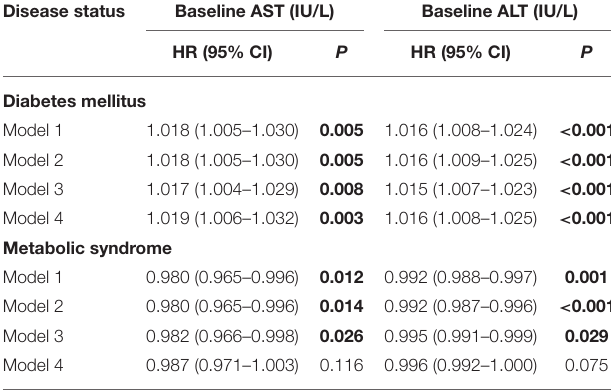
Model 2: adjusted for age, sex and income. Model 3: adjusted for model 2, waist circumference, SBP and DBP. Model 4: adjusted for model 3, HbA1c, triglyceride, cholesterol, HDL and eGFR. p < 0.05 used and statistically significant results